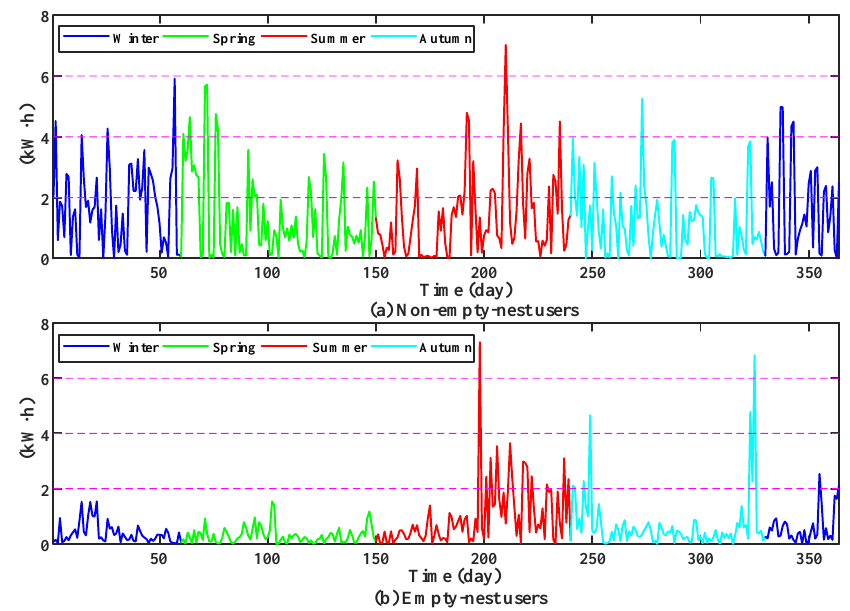
Figure 2. Chart of electricity consumption after differential treatment.